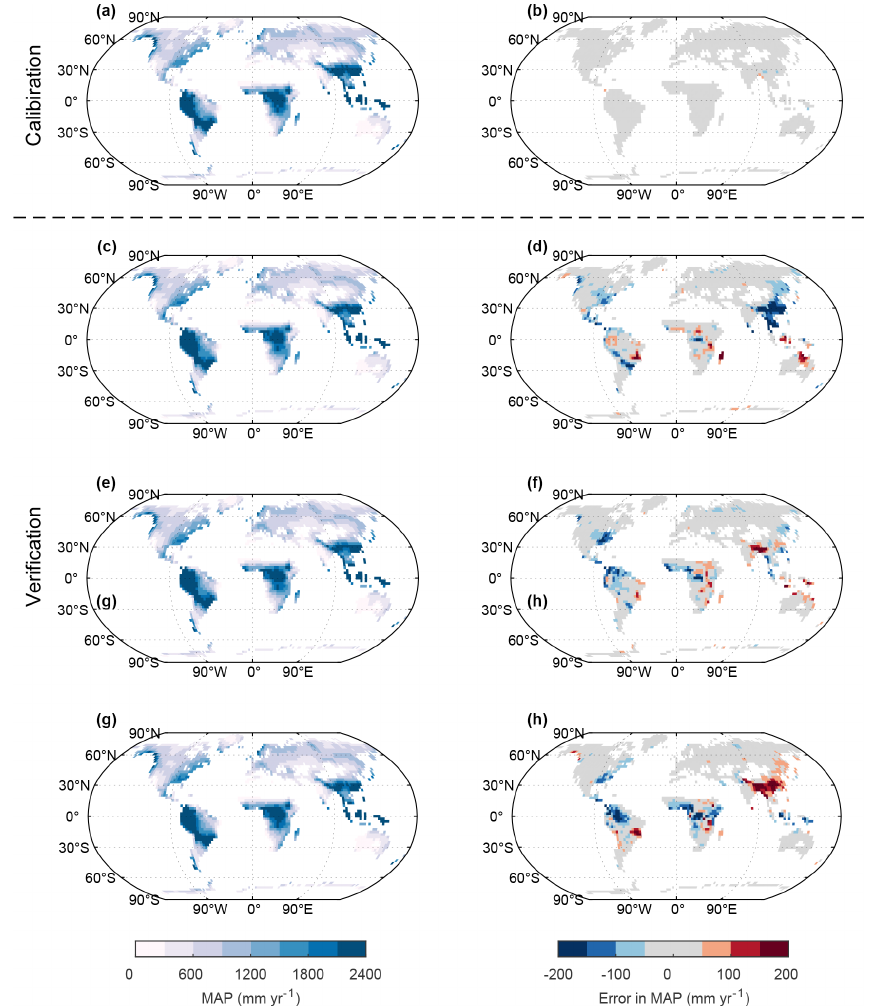
Figure 7. The spatial pattern of MAP in 2071–2100 from (a) multi-model mean of ESMs and (b) the error in MAP from emulation from PREMU. (c, d) SSP1–2.6; (e, f) SSP2–4.5; (g, h)